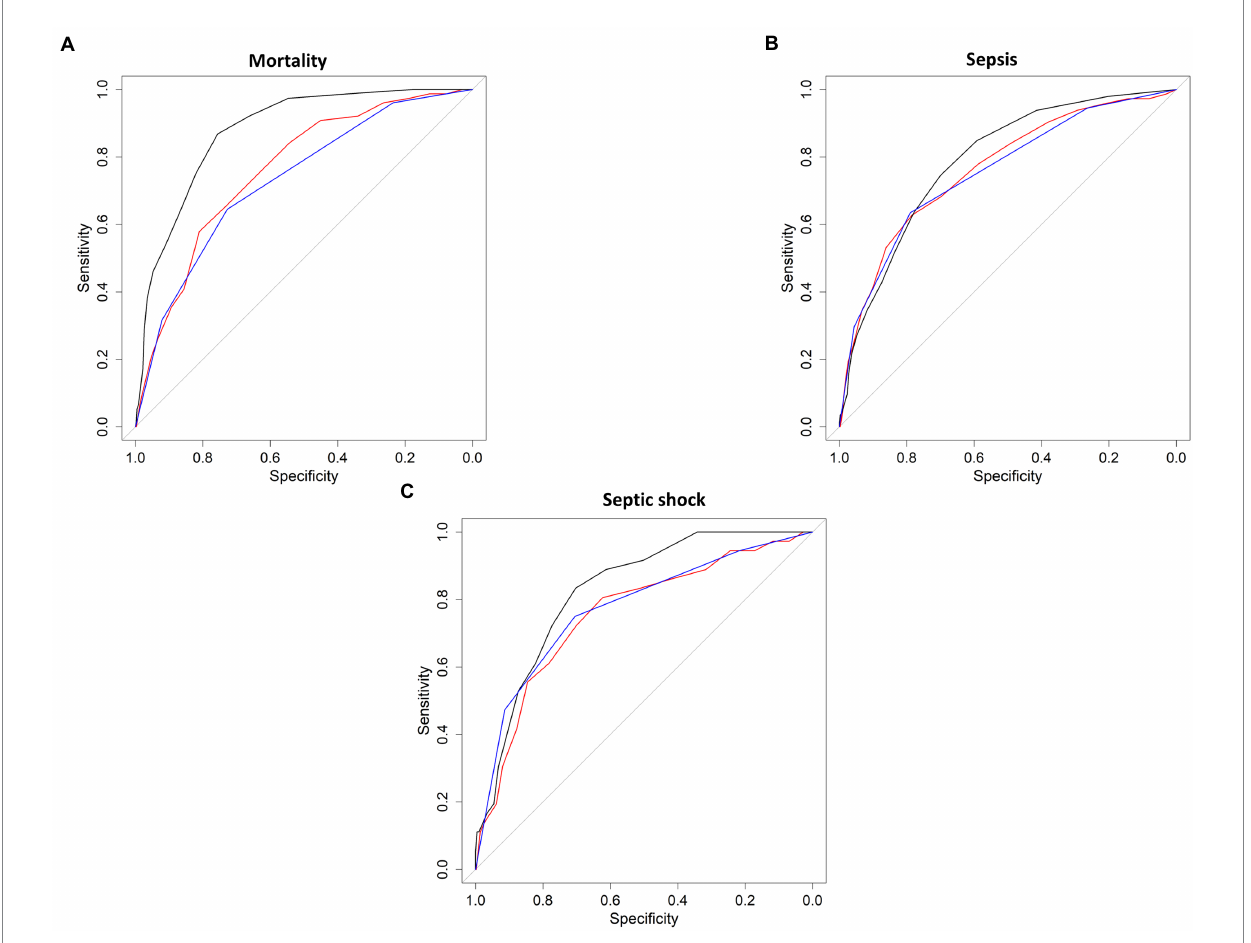
FIGURE 3 Discrimination capacity of each model. Solid line shows the receiver operating characteristic (ROC) curve for mortality (A) , sepsis (B) , and septic shock (C) . black line = mSOFA, red line = NEWS2, blue lines =